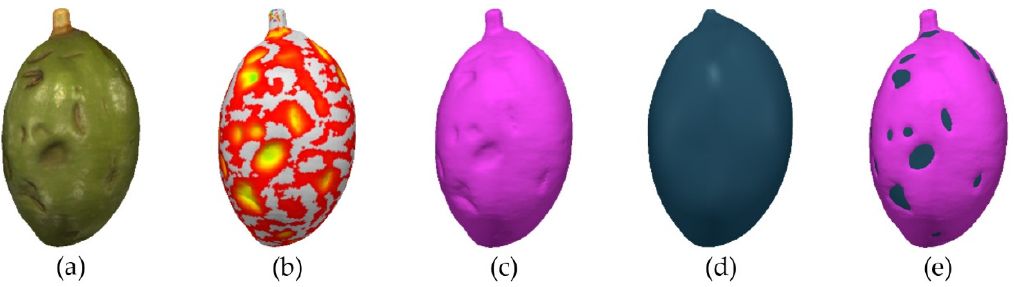
Figure 6. Creation of 3D virtual olive: ( a ) 3D mesh texturing; ( b ) curvature; ( c ) 3D mesh generation; ( d ) virtual olive, and ( e ) superposition of ( c , e ).